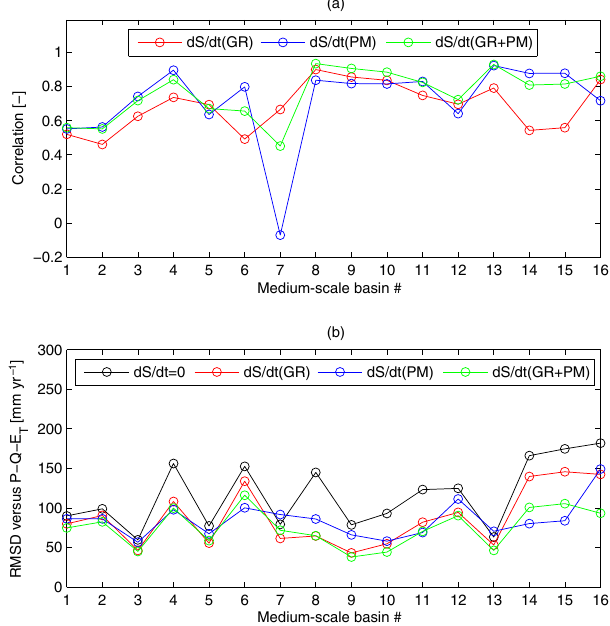
Figure 9. For the 16 medium-scale basins listed in Table 1: (a) the linear correlation between annual P − Q − E T and various annual d S / d t estimates and (b) the RMSD between P − Q − E T and vari- ous d S / d t estimates. Basins are ordered from drier to wetter (from left to right) and basin numbering corresponds to listing in Fig.